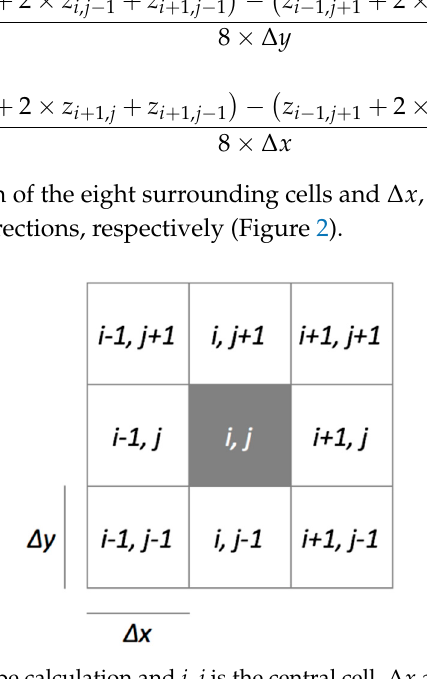
Figure 2. 3 × 3 kernel for slope calculation and i , j is the central cell. ∆ x and ∆ y are the dimensions of individual cells.